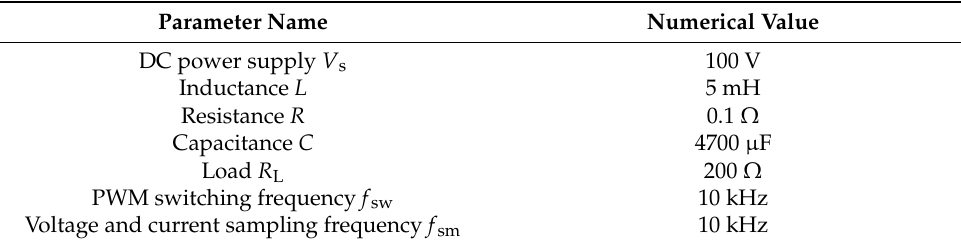
Table 1. The parameters of the DC microgrid system